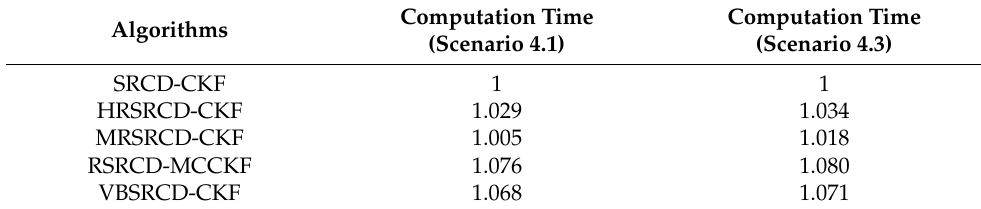
Table 3. The relative computation time of each